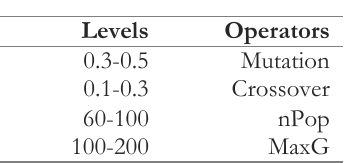
Table 10. NSGA-II algorithm parameter